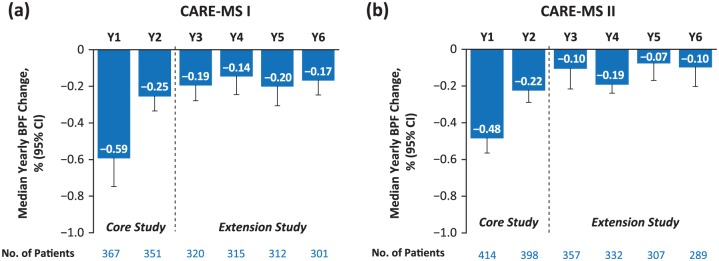
Median annual change in brain volume, measured by BPF, in alemtuzumab-treated patients enrolled in the extension from CARE-MS I (a) or II (b).32BPF, brain parenchymal fraction; CARE-MS, Comparison of Alemtuzumab and Rebif® Efficacy in Multiple Sclerosis; Y, year.